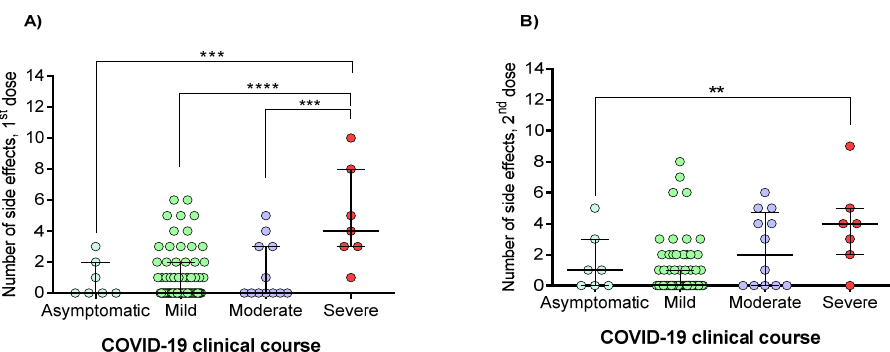
Figure 3. Relationship between prior COVID-19 clinical course with the number of vaccine-associated side effects. ( A ) Side effects after a singles dose; ( B ) Side effects after the second dose. The difference between all groups was calculated with the Kruskal–Wallis test, followed by Dunn’s multiple comparison test. Data are provided as median and interquartile ranges. **, p < 0.01; ***, p < 0.001; ****, p < 0.0001.